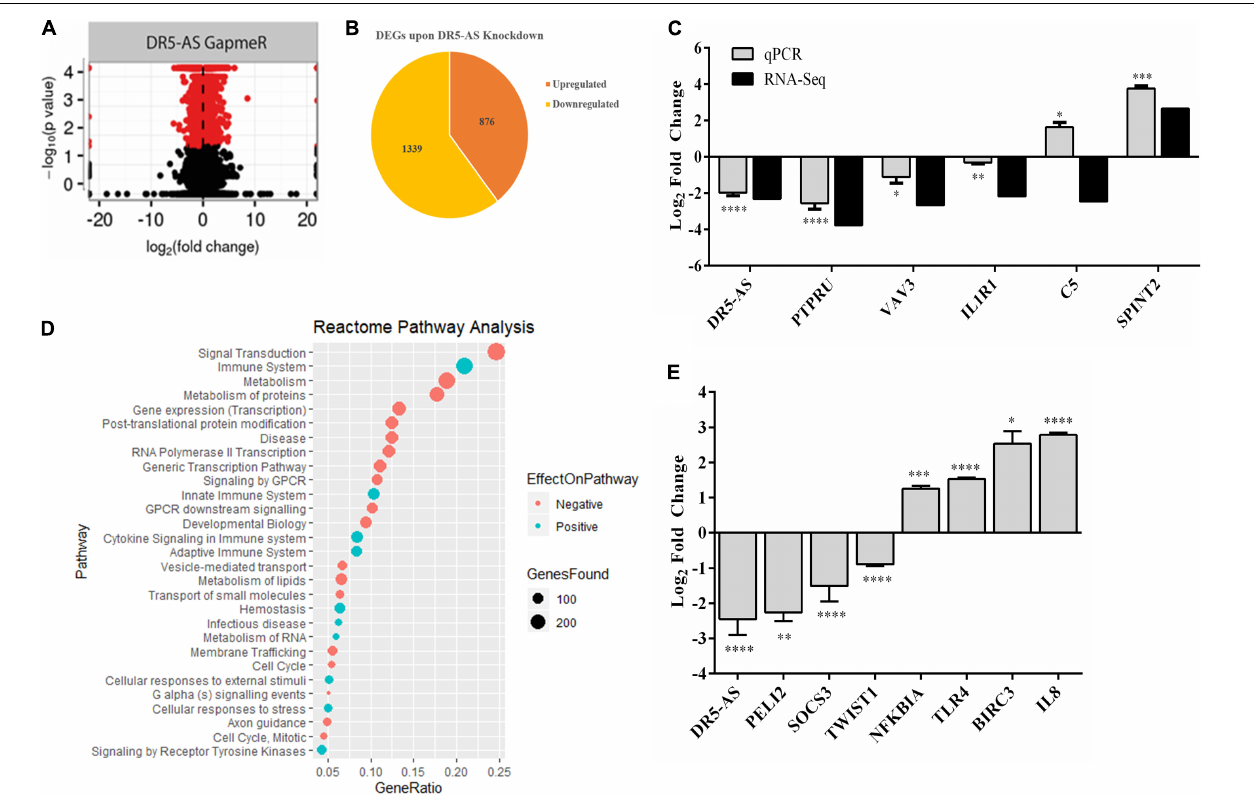
FIGURE 5 | DR5-AS-knockdown-mediated perturbations in gene expression. Total RNAs isolated from HeLa cells transfected with negative GapmeR or DR5-AS GapmeR were subjected to RNA-seq. A volcano plot and pie chart of differentially expressed genes after knockdown are presented in (A,B) , respectively. (C) qPCR validation of some genes differentially expressed in DR5-AS knockdown HeLa cells. (D) Reactome Pathway analysis of genes differentially expressed in HeLa cells transfected with DR5-AS GapmeR. (E) qPCR analyses of immune system-related genes as determined to be differentially expressed based on the Reactome pathway analysis. ∗ p ≤ 0.05, ∗∗ p ≤ 0.01, ∗∗∗ p ≤ 0.001, and ∗∗∗∗ p ≤